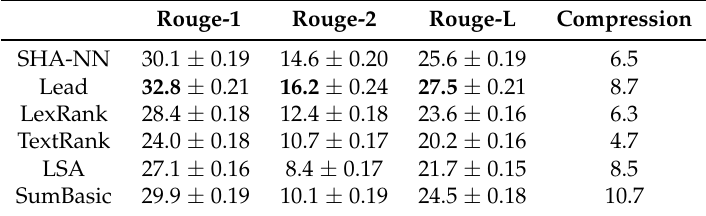
Table 3. Results on ES-NEWS corpus with respect to the ground truth (full length Rouge F 1 ).